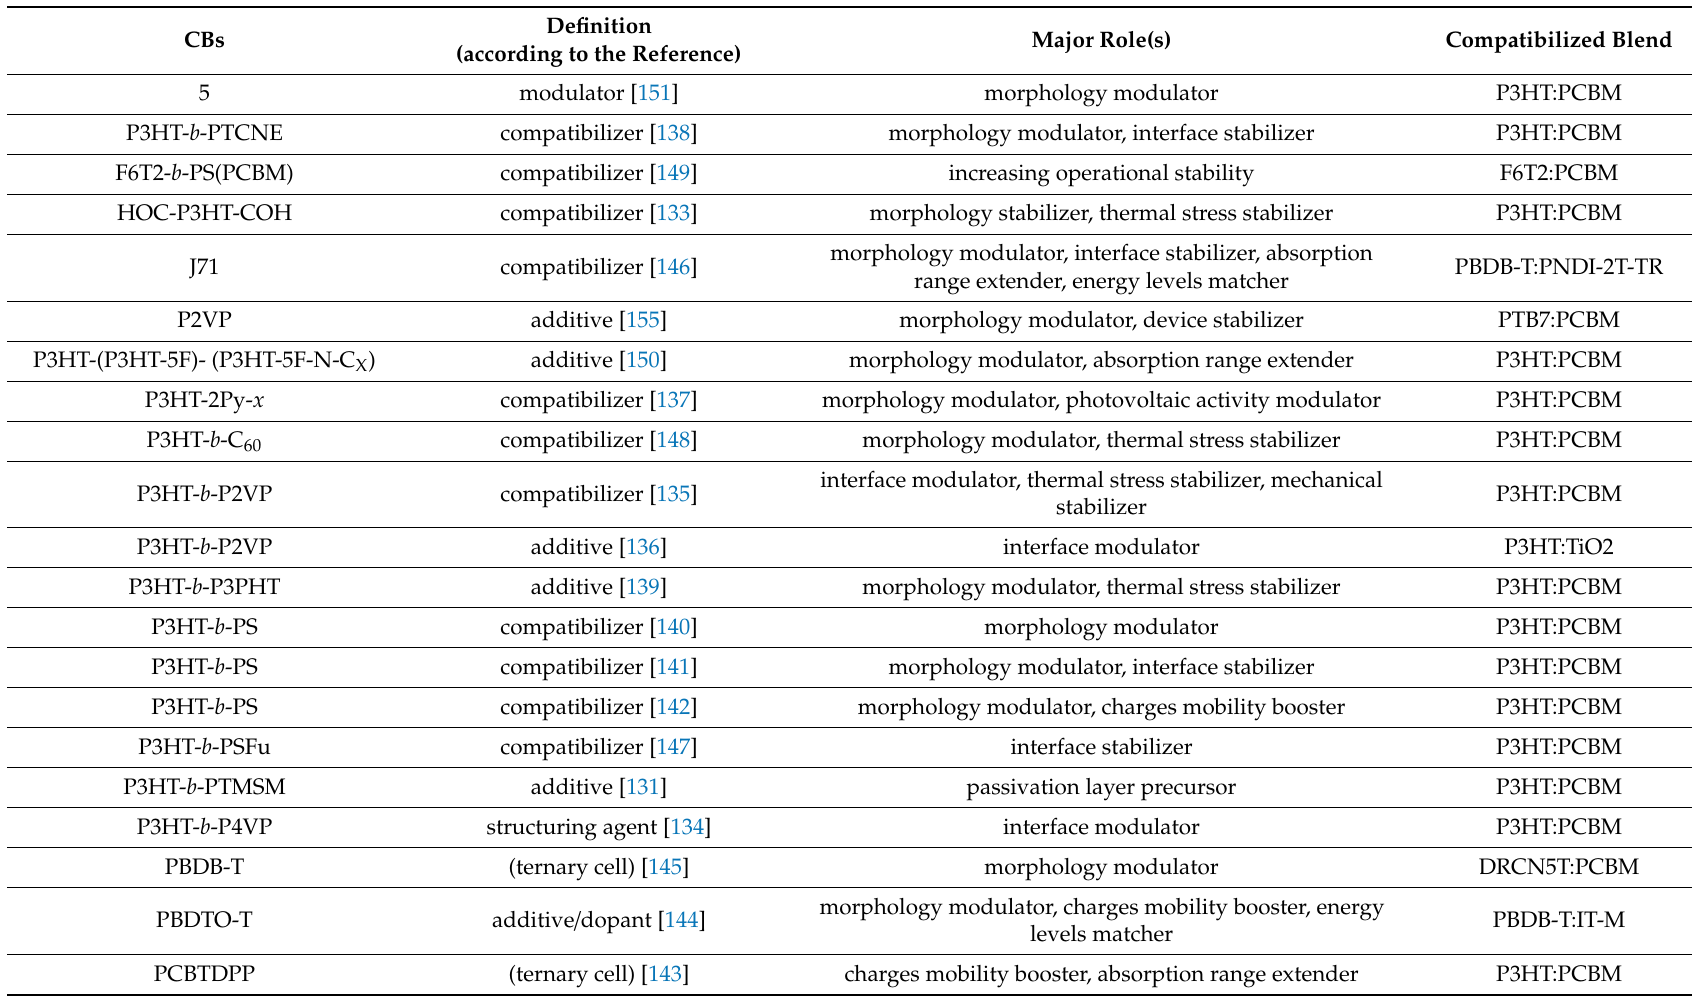
Table 1. A summary of the polymeric CBs, including the nomenclature provided in the reference articles, the major role(s) played in the device, and the compatibilized blend. CBs are reported according to the label provided by the authors in the cited article and reported by us in Figure